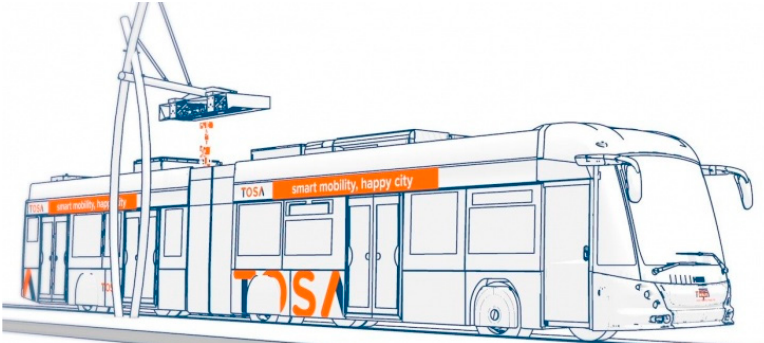
Figure 3. TOSA electric bus.